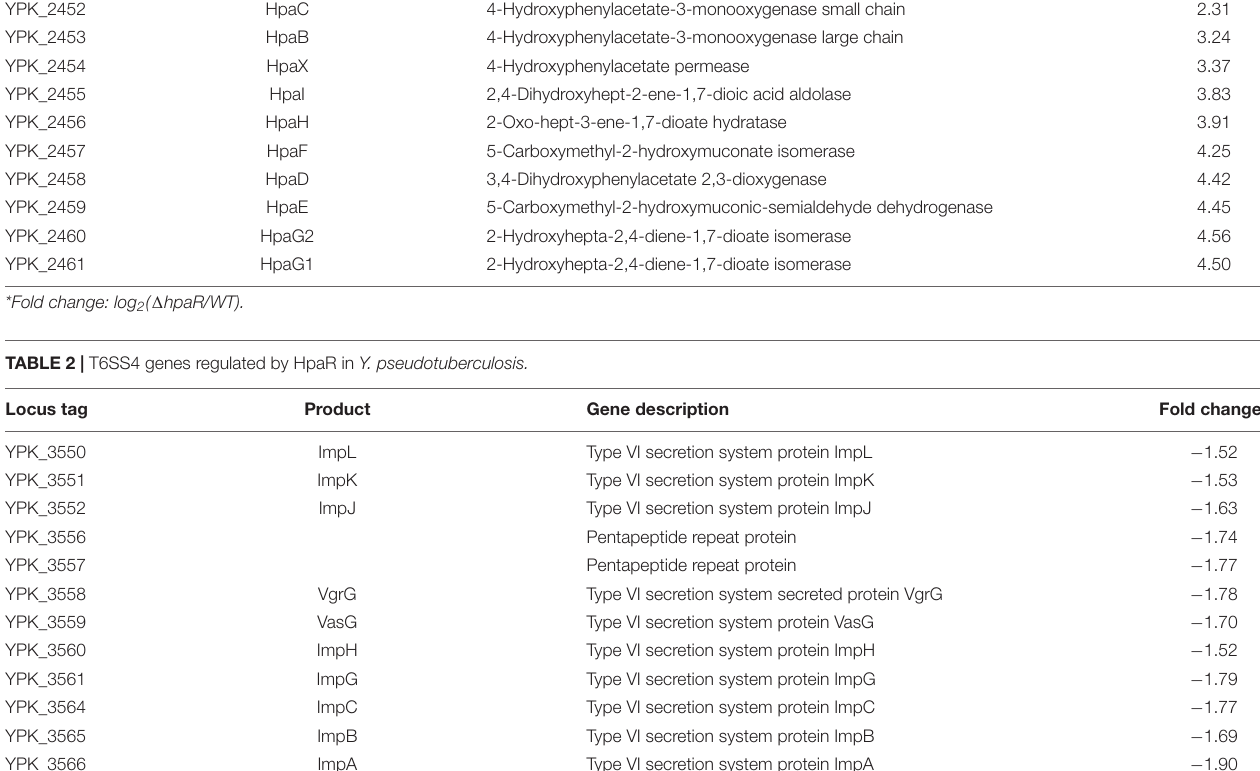
TABLE 1 | The hpa-meta operon genes regulated by HpaR in Y. pseudotuberculosis. Locus tag Product Gene description Fold change*